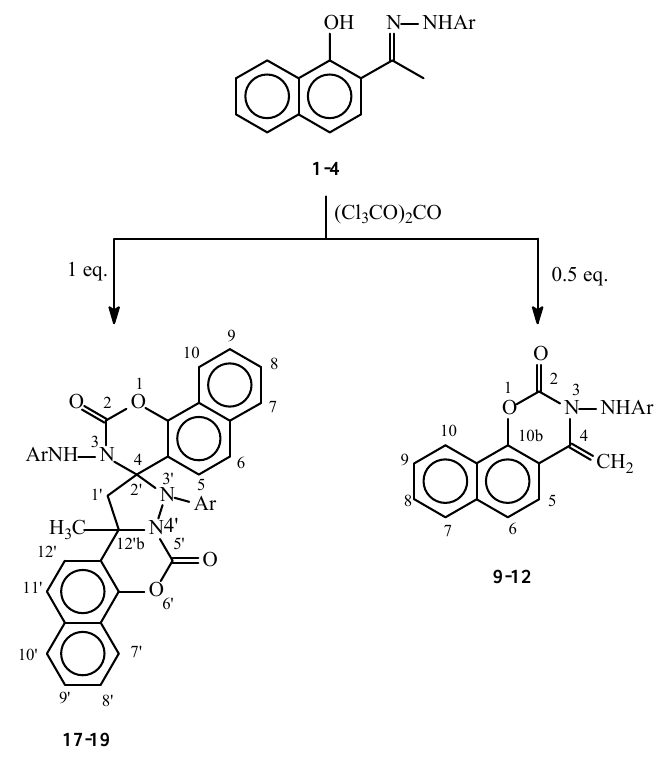
Scheme 2. Reaction of hydrazones 1-4 with triphosgene.